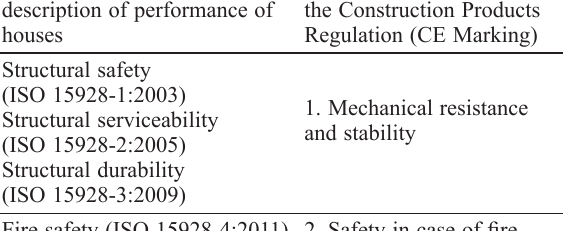
Table 6. Correspondences between ISO 15928 attributes and CPR basic requirements Attributes covered by the ISO 15928 standard for the description of performance of